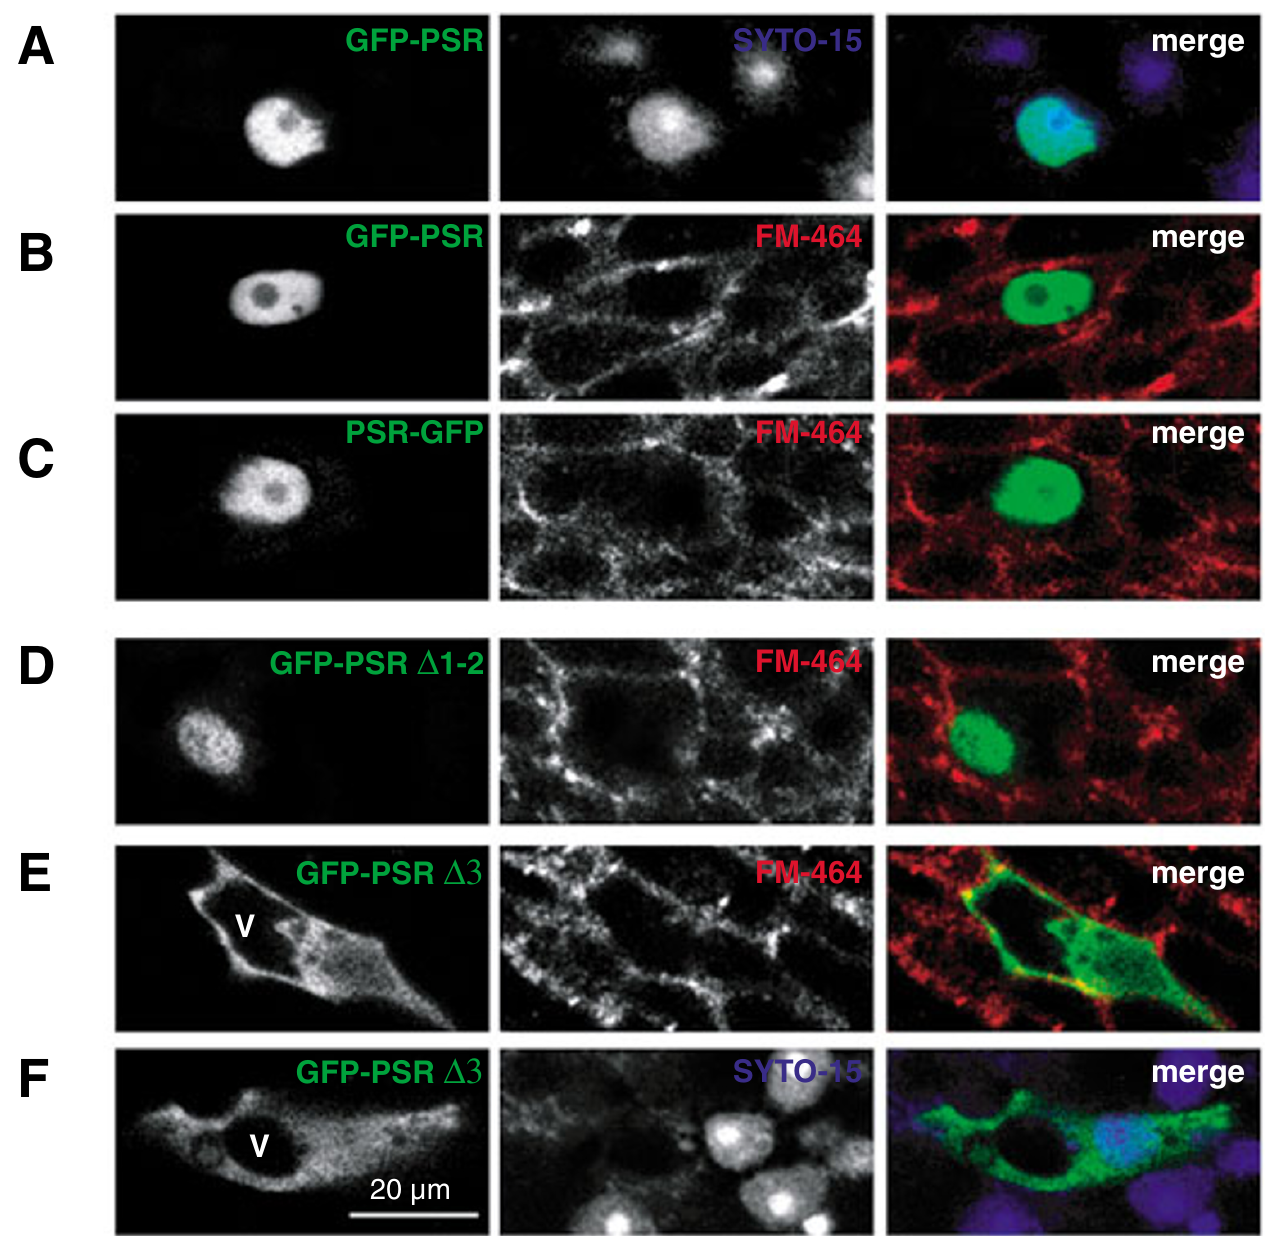
Figure 4 PSR localisation in living animals Single optical sections of GFP expressing cells of living hydra after transfection with GFP- PSR (A and B), PSR-GFP (C), NLS-mutants NLS1-2 (D) and NLS3 (E and F). Left hand panels show GFP, middle panels nuclear staining with SYTO-15 or membrane staining with FM-464 as indicated. Right hand panels are merged images. V indi- cates vacuoles typically seen in living hydra